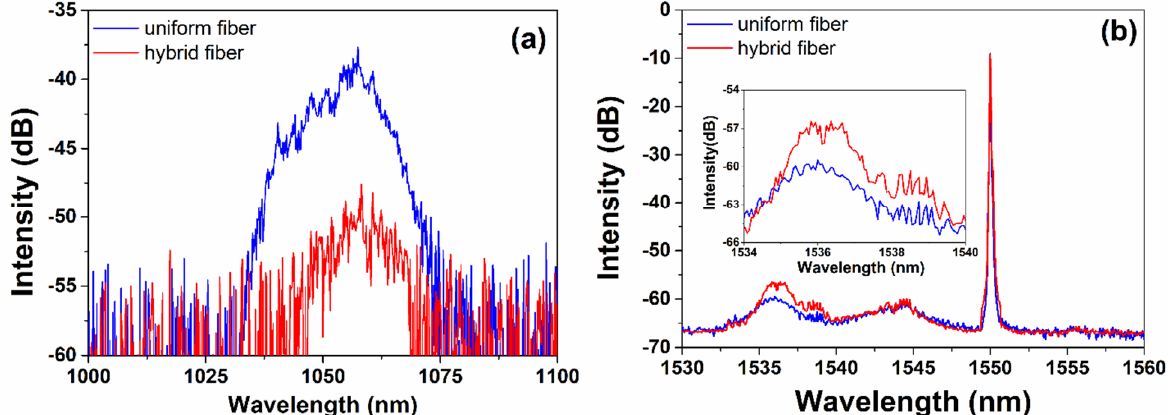
Figure 5. (a) Output spectra in the range of 1000 to 1100 nm. (b) The output spectra of the hybrid and uniform fiber amplifier in the 1530 to 1560 nm region. The insertion is the zoomed spectra in the range of 1534 to 1540 nm.